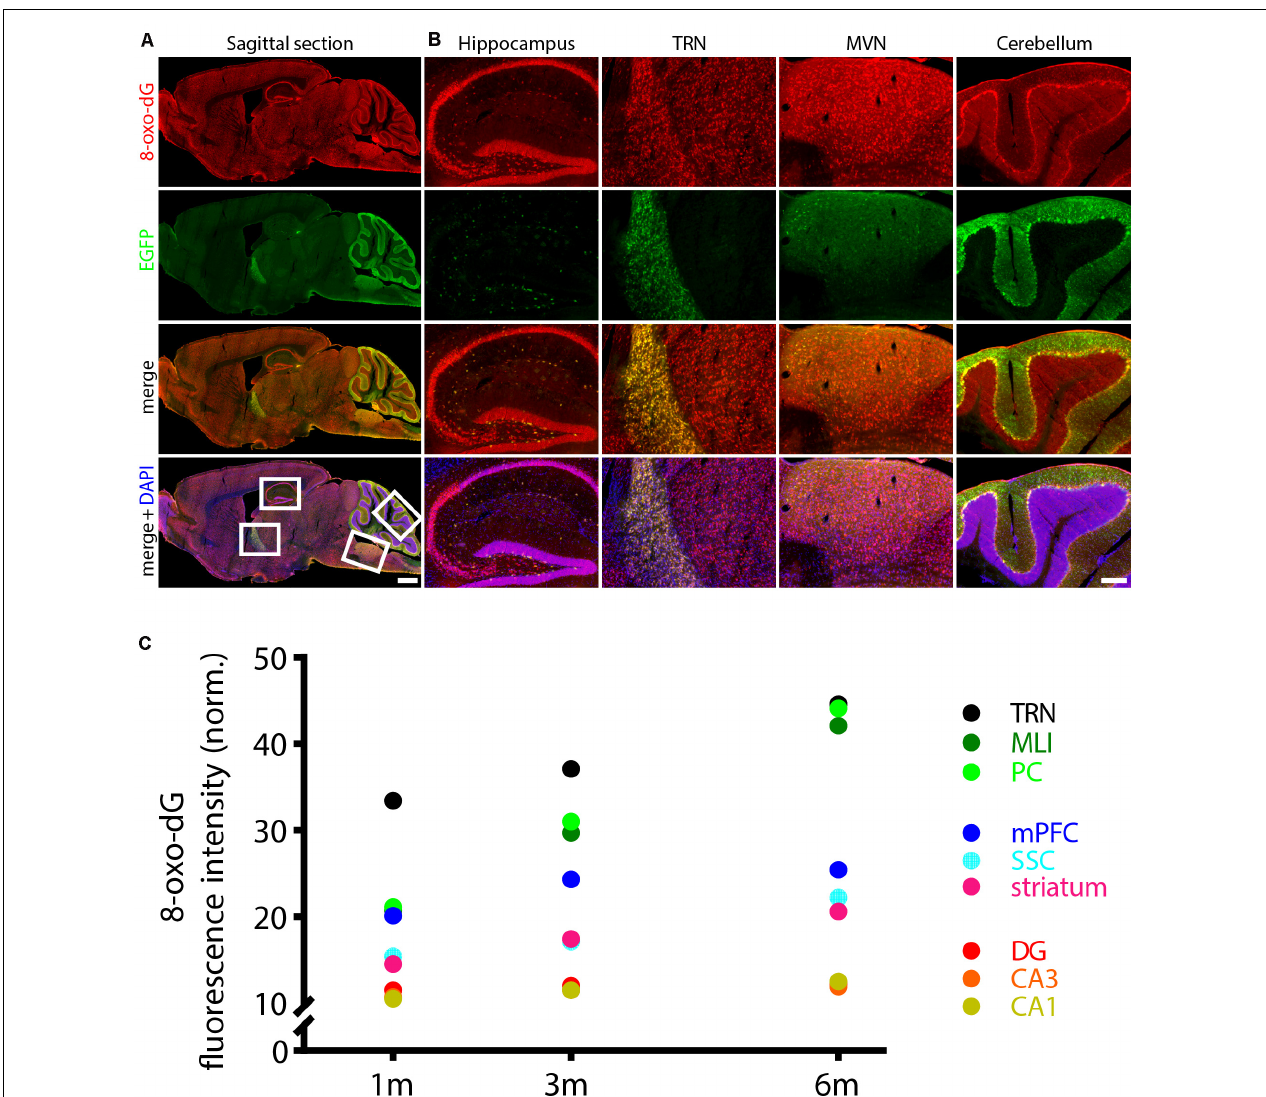
FIGURE 1 | Age-dependent increase in oxidative stress in WT Pvalb neurons evidenced by 8-oxo-dG staining. (A) Sagittal brain section from a 3-month old WT mouse stained for 8-oxo-dG (oxidative stress marker, red), EGFP (Pvalb neurons expressing EGFP, green) and DAPI (nuclei, blue). Regions with strong 8-oxo-dG staining (white boxes in low-left image in A ) –hippocampus, TRN, MVN and cerebellum– are shown at higher magnification in (B) . Note the higher densities of EGFP + Pvalb neurons and/or neuropil (fibers) in these regions resulting in partial yellow staining in the merged images. Scale bar in (A) 1 mm, in (B) 200 µ m. Sagittal brain sections scanned by the NanoZoomer serve for demonstration purposes and were not analyzed in the study. (C) Quantitative analyses were performed on confocal microscopy images. Brain sections were scanned in nine regions – 3 hippocampal regions (CA1, CA3, and DG), striatum, SSC, mPFC, 2 cerebellar regions [Purkinje cell layer (PC) and in molecular layer interneurons (MLI)] and TRN. Fluorescence signal quantifications were carried out in 1, 3, and 6-months old mice [normalized values (mean ± SD) are reported in Table 1 ]; for clarity, error bars and regression lines are omitted; R 2 values are from linear regression analyses using the three time points: 1, 3, and 6 months and are listed in Table 1 .